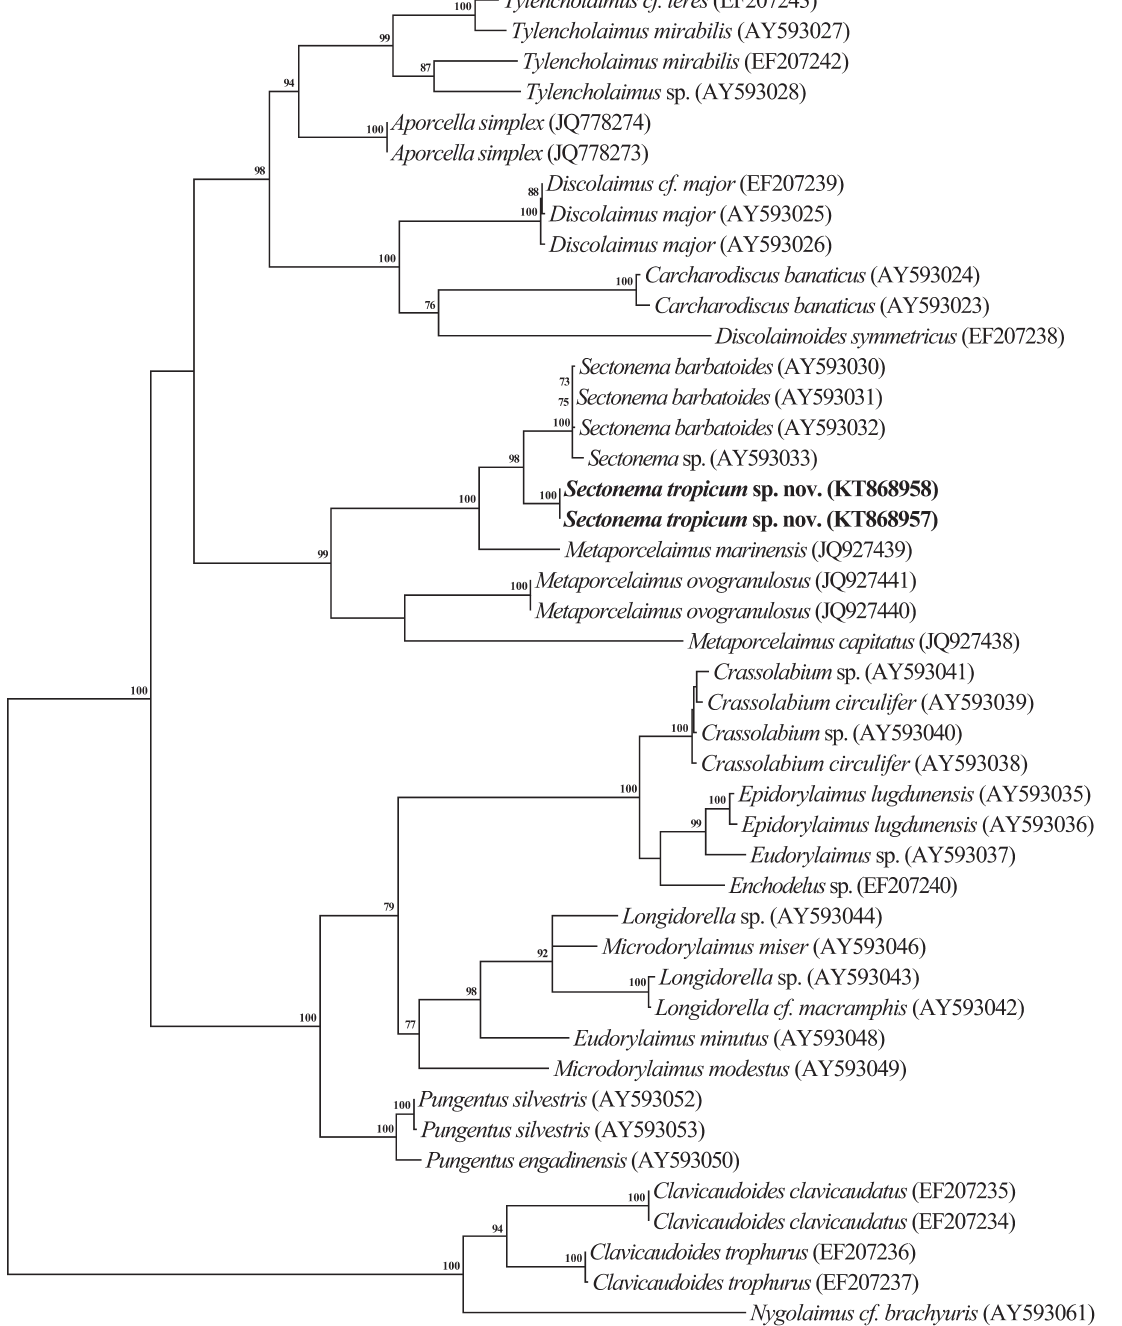
Fig. 6. Maximum Likelihood tree as inferred from D2–D3 expansion segments of 28S rRNA gene sequence alignments under the GTR + I + G model. Bootstrap values are given for appropriate clades. Newly obtained sequences are indicated by bold